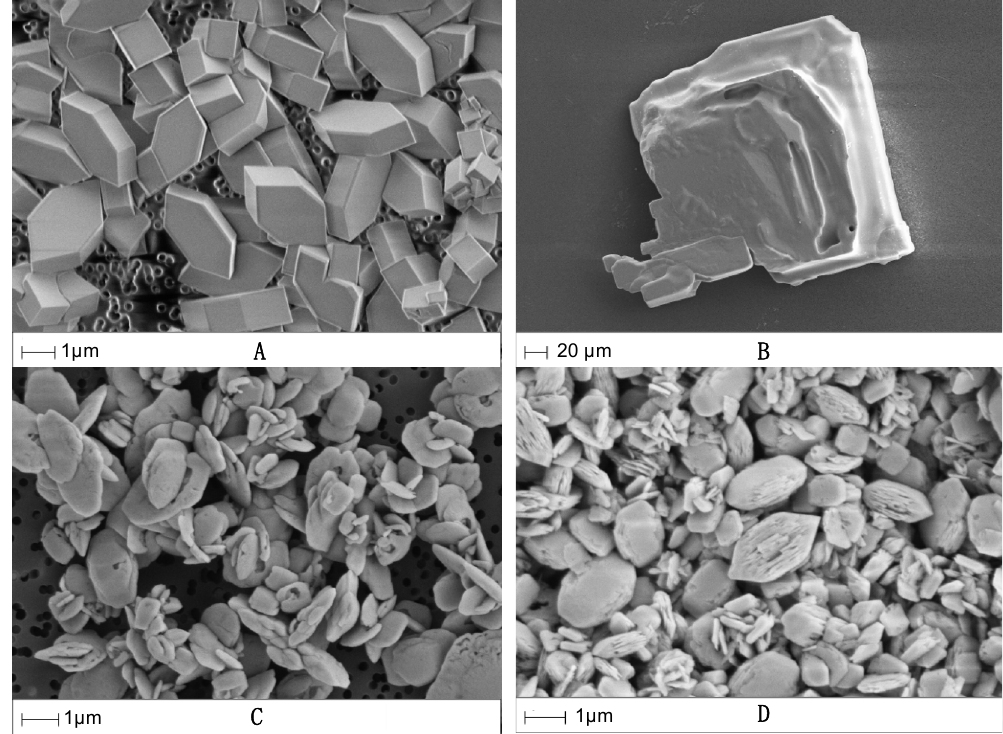
Figure 2. High ‐ resolution SEM images of the radiobarite crystals formed in 0.3 and 3 M NaCl solutions at di ff erent initial Ba 2 + concentrations. ( A ) 0.3 M NaCl with 0.22 mM Ba 2 + and 1.5 mM SO 42 − ; ( B ) 3 M NaCl with 0.22 mM Ba 2 + and 15 mM SO 42 − ; ( C ) 0.3 M NaCl with 5 mM Ba 2 + and 0.5 mM SO 42 − ; ( D ) 3 M NaCl with 5 mM Ba 2 + and 0.5 mM SO 42 −